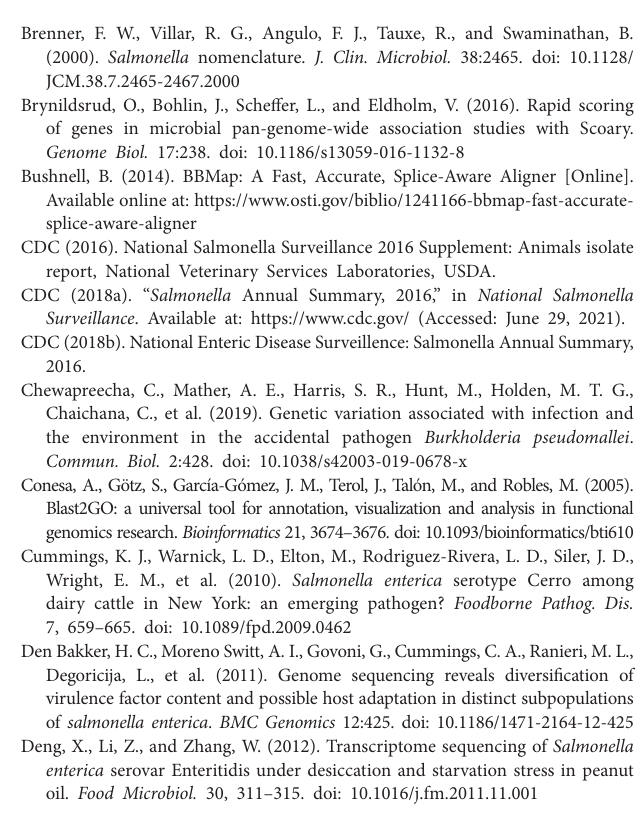
Supplementary Figure S1 | Initial phylogenetic analyses revealed a polyphyletic structure for S. Cerro. Maximum likelihood phylogenetic tree of S. Cerro (blue), S. Javiana (purple), and S. Typhimurium (pink) isolates constructed with core SNPs from 21 S. Cerro genomes, 16 S. Javiana genomes, and 16 S. Typhimurium genomes representing isolates with a range of isolation dates, sources, and locations, indicating polyphyly in S. Cerro. Isolates characterized by RNA-seq are shown in bold font. A general time-reversible model with gamma-distributed substitution sites was used for constructing the maximum likelihood tree in RAxML